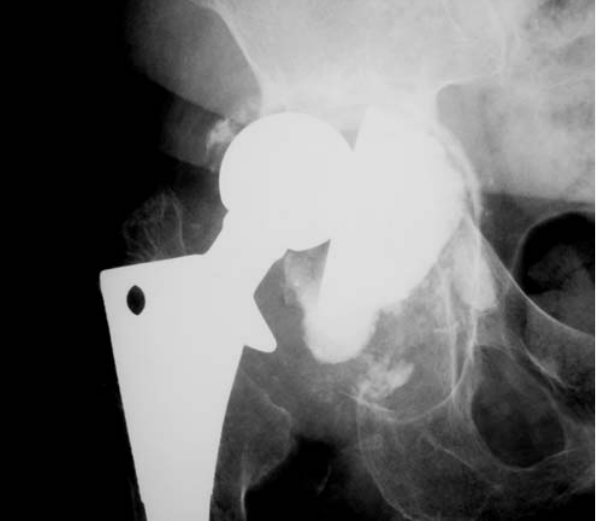
Figure 2 - Anteroposterior radiography of an acetabular loosening, type IV deficiency by D’Antonio et al Table 3 - Radiographic results